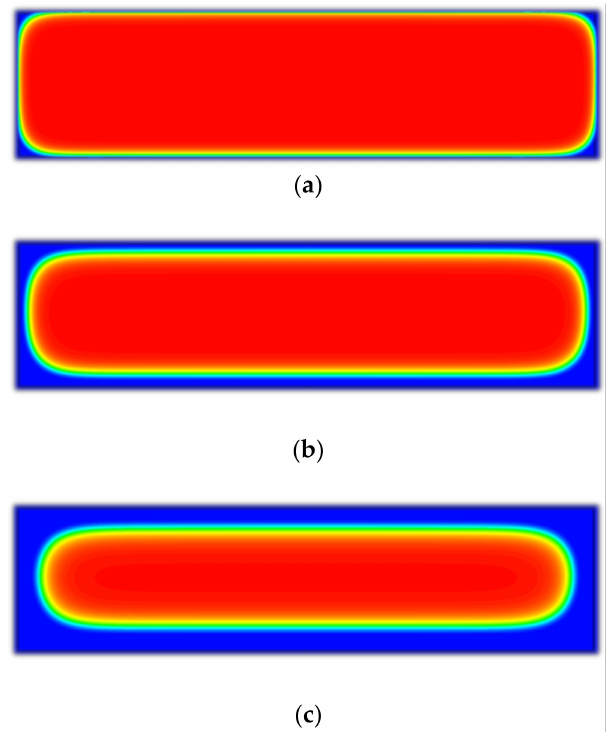
Figure 15. Concentration of initial moisture at ( a ) t = 5 s, ( b ) 10 s and ( c ) 15 s. Particle Devolatilization